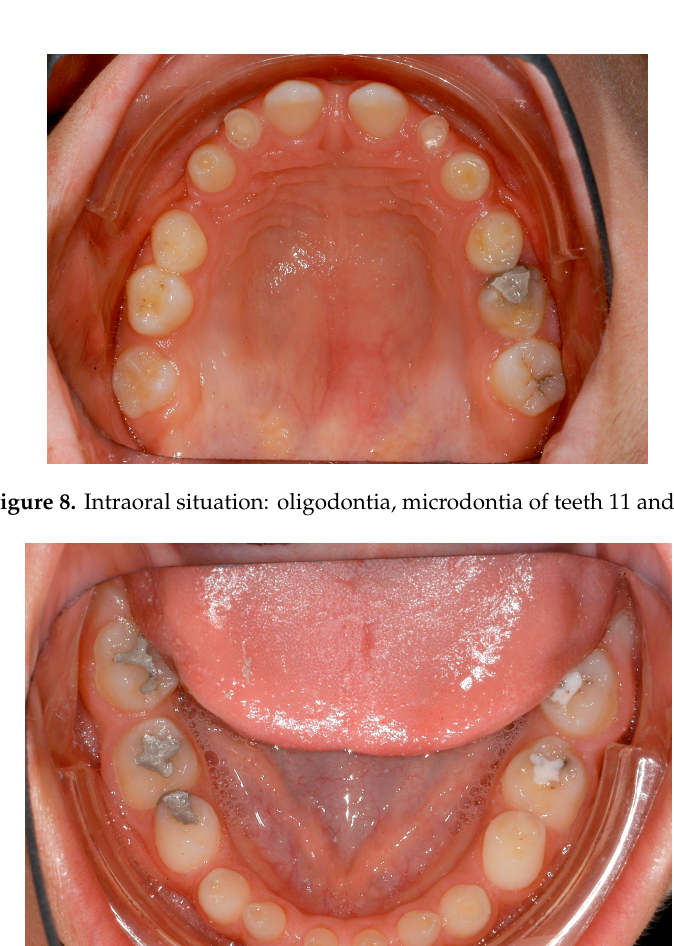
Figure 7. Intraoral situation: oligodontia, microdontia of teeth 11 and 21 and a pronounced lateral open bite.